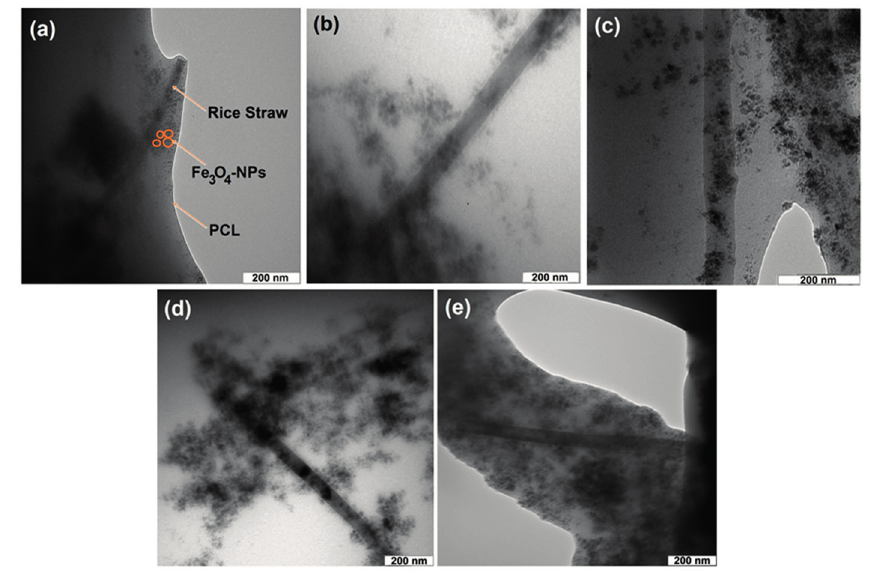
Figure 2. Transmission electron microscopy micrograph of ORS/Fe 3 O 4 /PCL-NCs in 1.0, 5.0, 15.0, 30.0 and 60.0 wt. % ( a – e